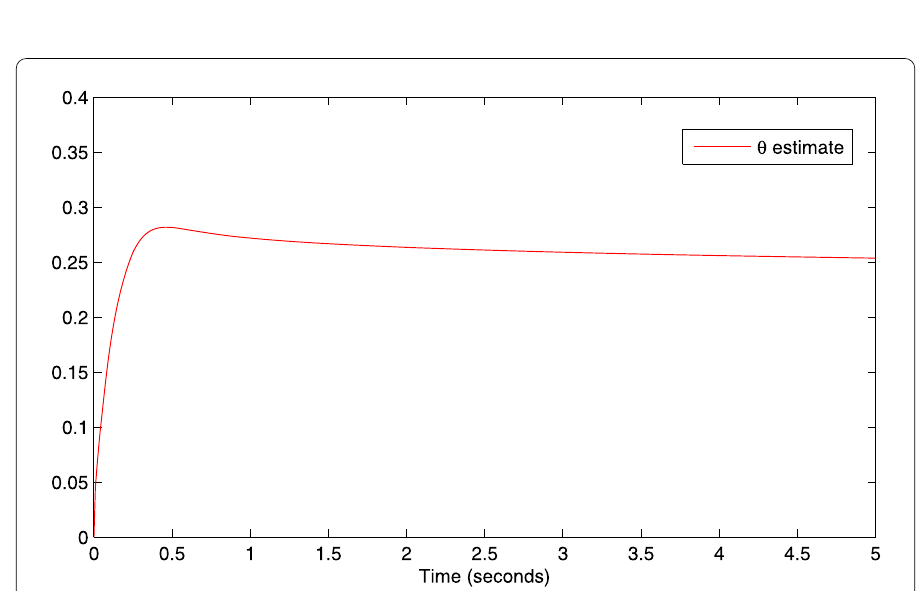
Figure 2 Control input u .